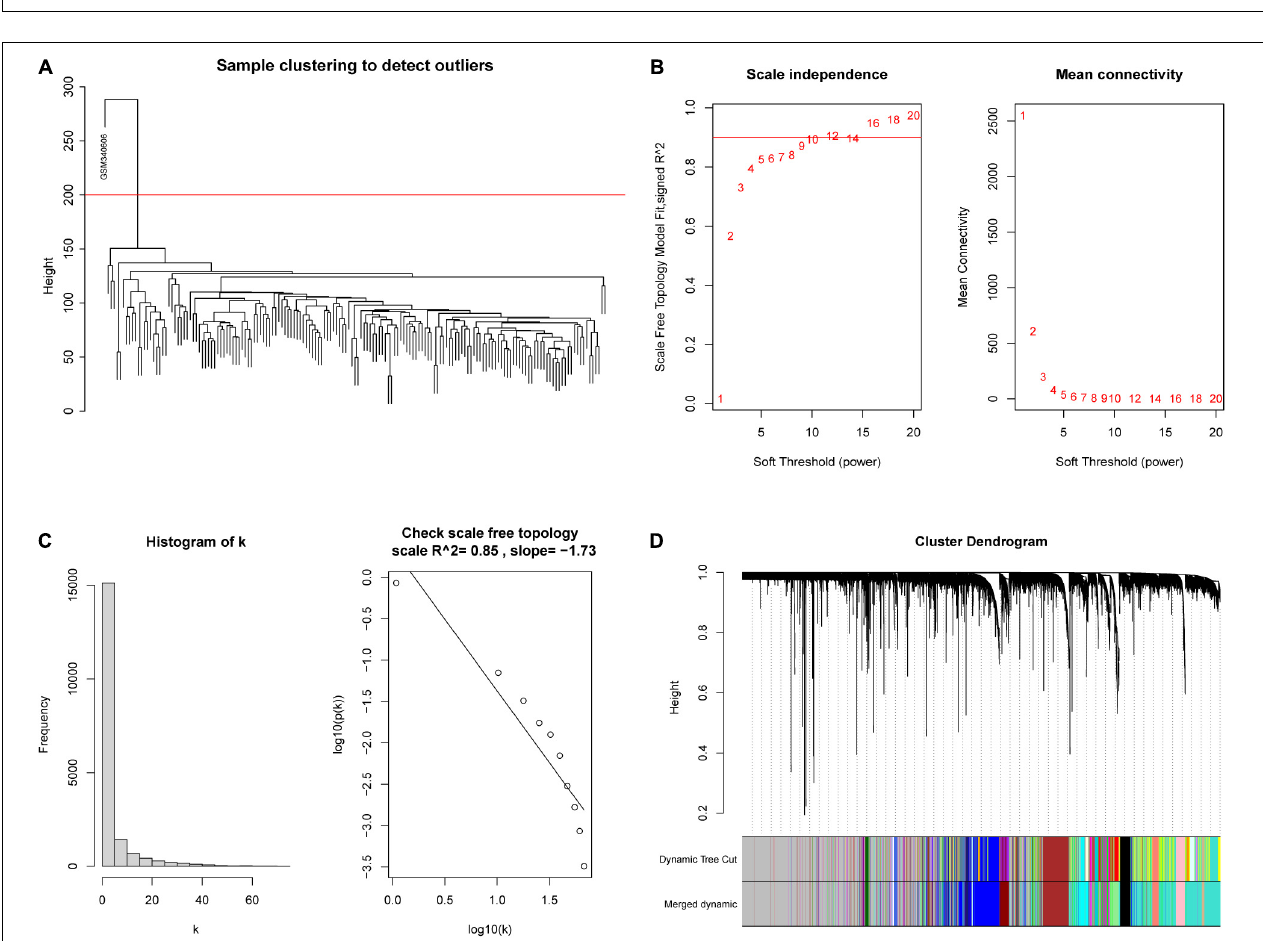
FIGURE 2 | Differentially expressed genes between patients with non-muscle invasive bladder cancer (NMIBC) and muscle invasive bladder cancer (MIBC) displayed as a heatmap (A) and a volcano map (B) .